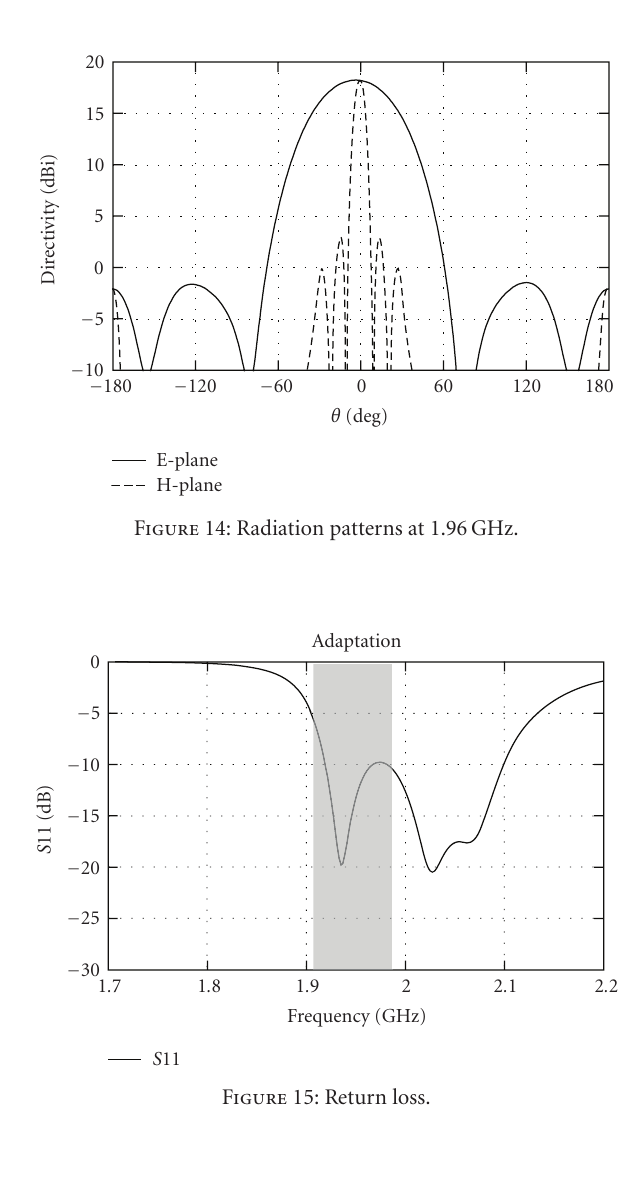
the − 3 dB directivity bandwidth raises from 8.4% to